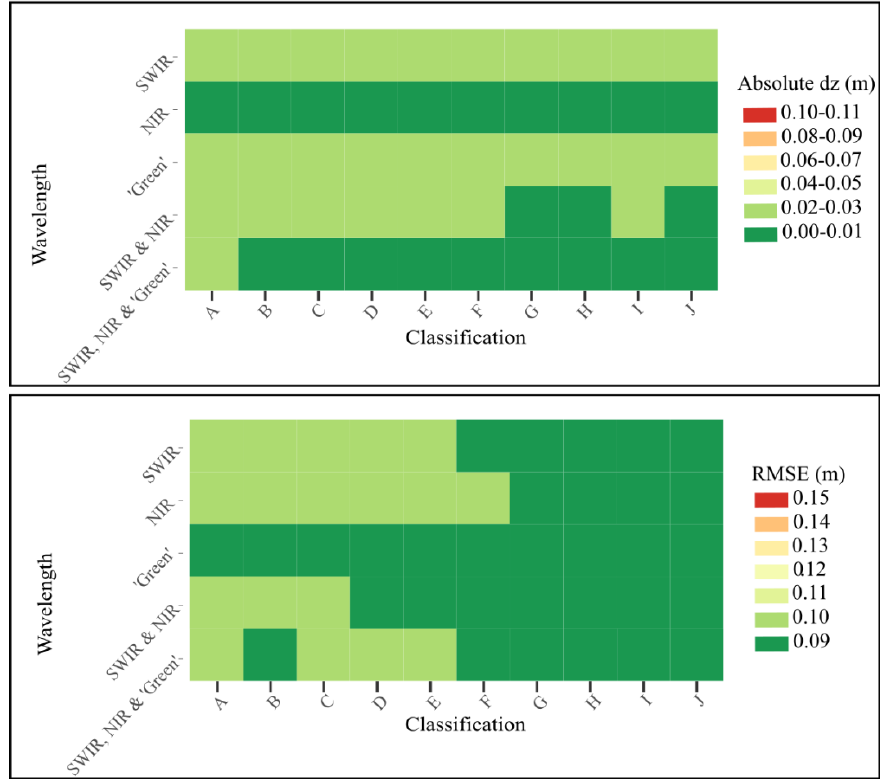
Figure 7. Ground classification results (| dz | and RMSE) in burned peatlands with low vegetation regeneration two years post-fire (as a proxy for immediately post-fire). Classifications were conducted in LAStools.